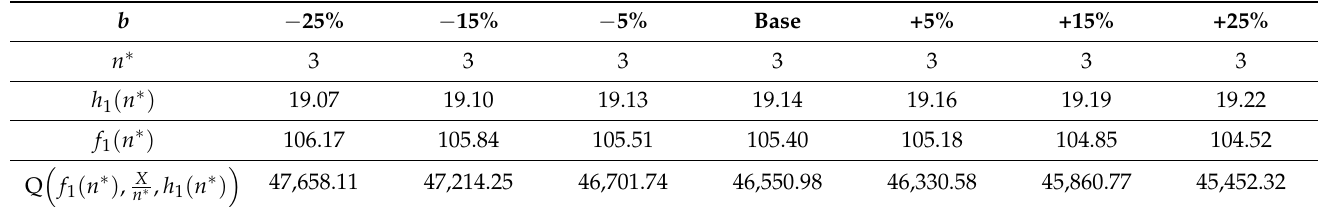
Table 4. Variation of the spacing between bus stops along a route b .